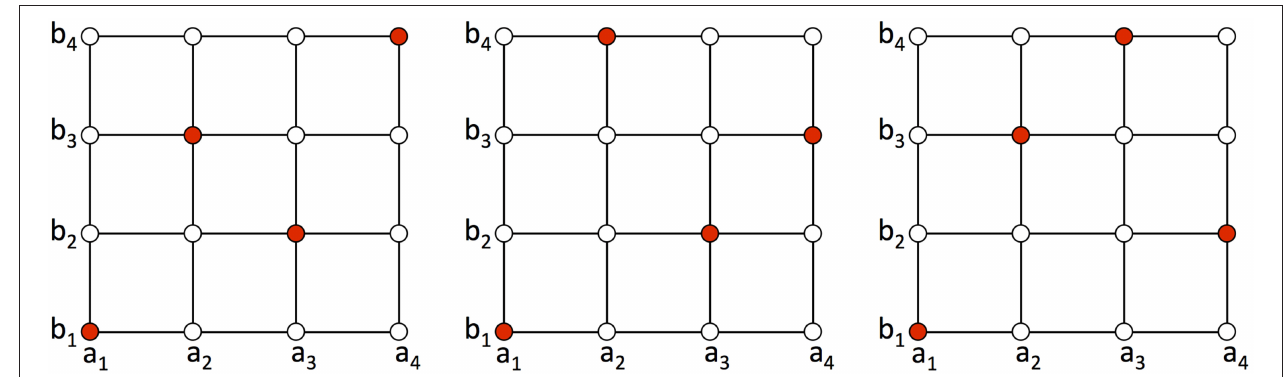
FIGURE 1 | Example of three designs generated via latin hypercube sampling (LHS) in 2D (red points). Note that each of these designs only possesses one point per column and per row, which is a special feature of LHS.